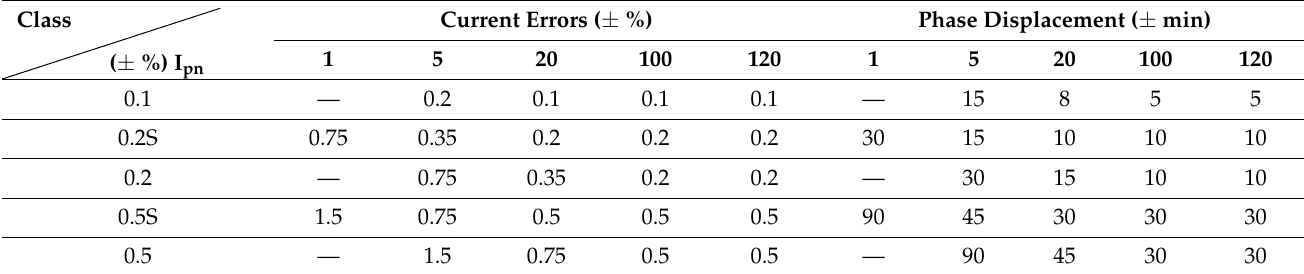
Table 1. Standard classes of current transformers according to IEC/EN